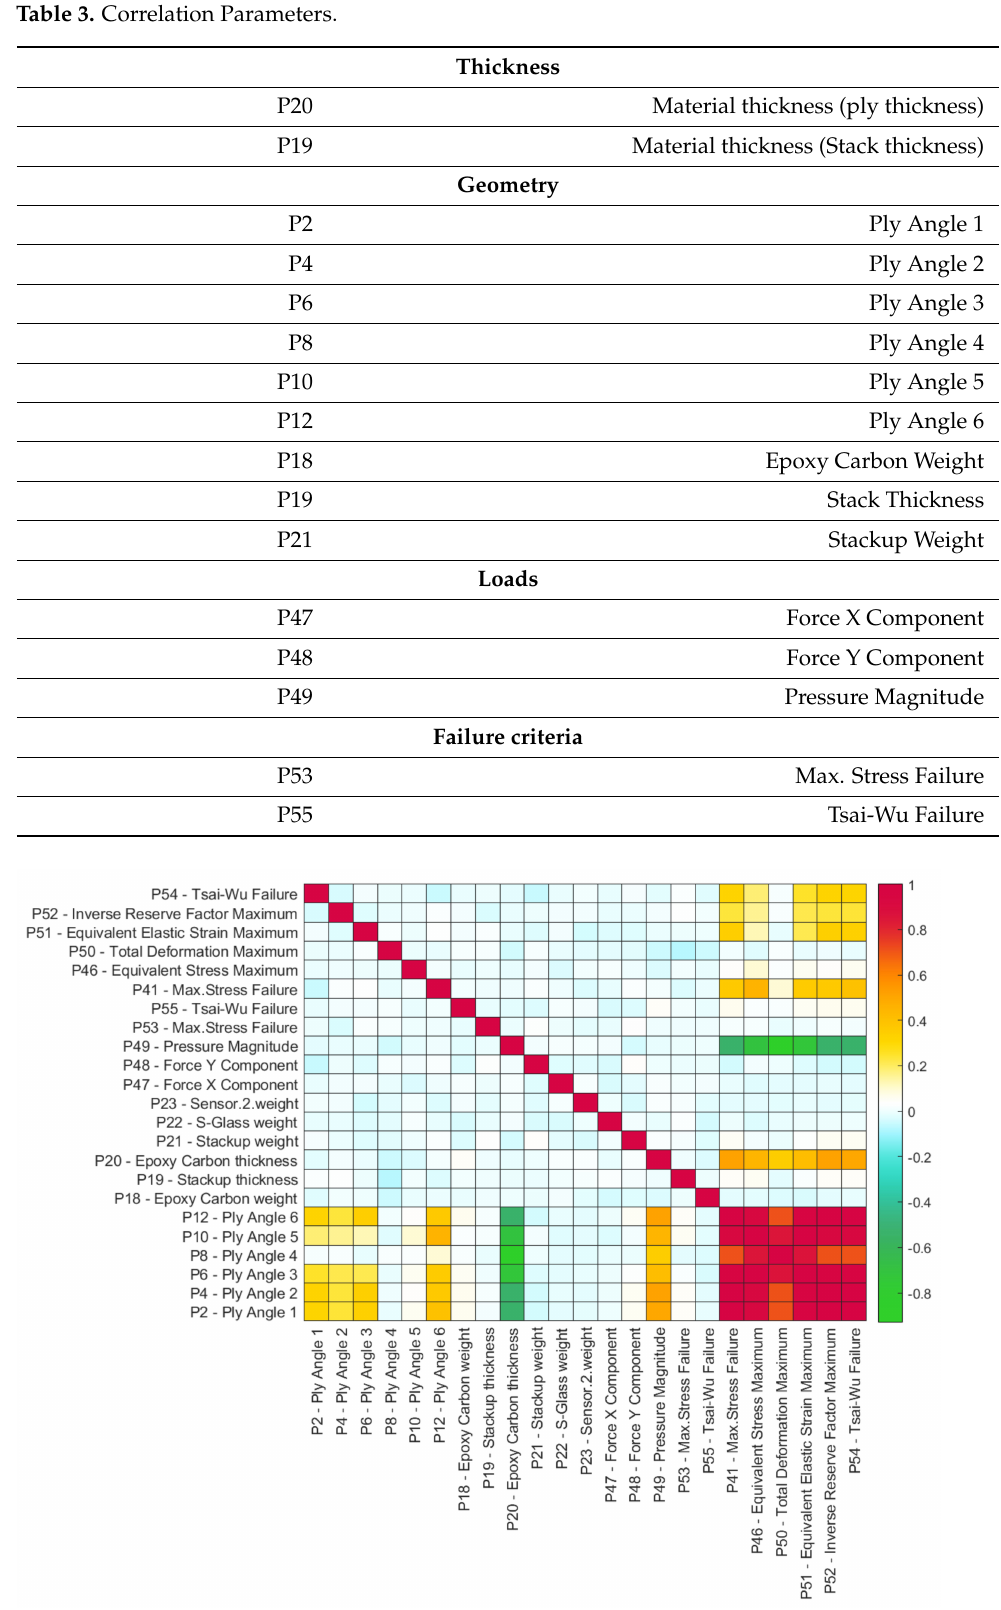
Figure 21. Parametric correlation